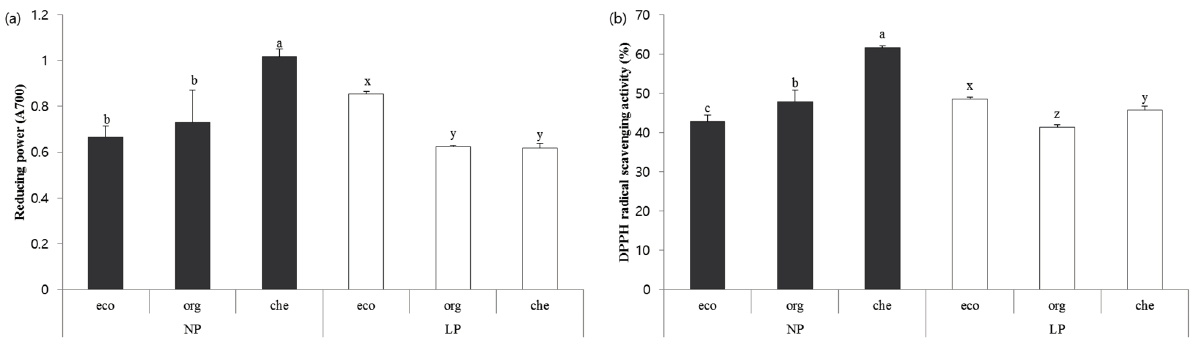
Figure 2. ( a ) Reducing power of chicory; ( b ) DPPH radical scavenging activity. All values are expressed as means ± standard deviation. Values with different letters denote